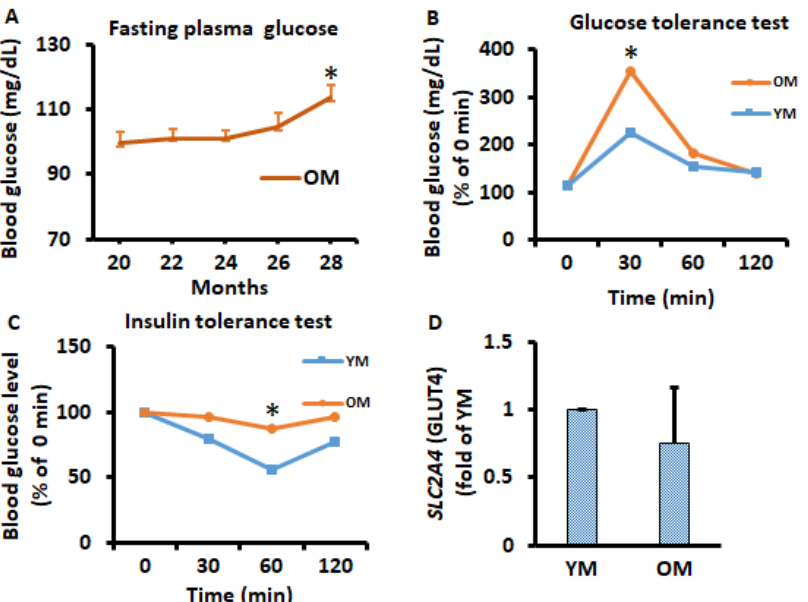
Figure 4. Time course of potential alterations in metabolism during the aging in vivo study. ( A ) Overnight fasting glucose was measured every 2 months in OM. ( B , C ) glucose tolerance tests and insulin tolerance tests were performed on month 9 in YM and month 26 of OM by intraperitoneal injection of glucose (2 g/kg body weight) and insulin (1 U/kg body weight. ( D ) SLC2A4 (GLUT4) gene expression was analyzed in EWATs from YM and OM using qPCR. Data were analyzed using one-way ANOVA and t -test, and significant differences from one-way ANOVA were further analyzed using Tukey’s test; * p < 0.05 compared to 20-month-old mice or YM.